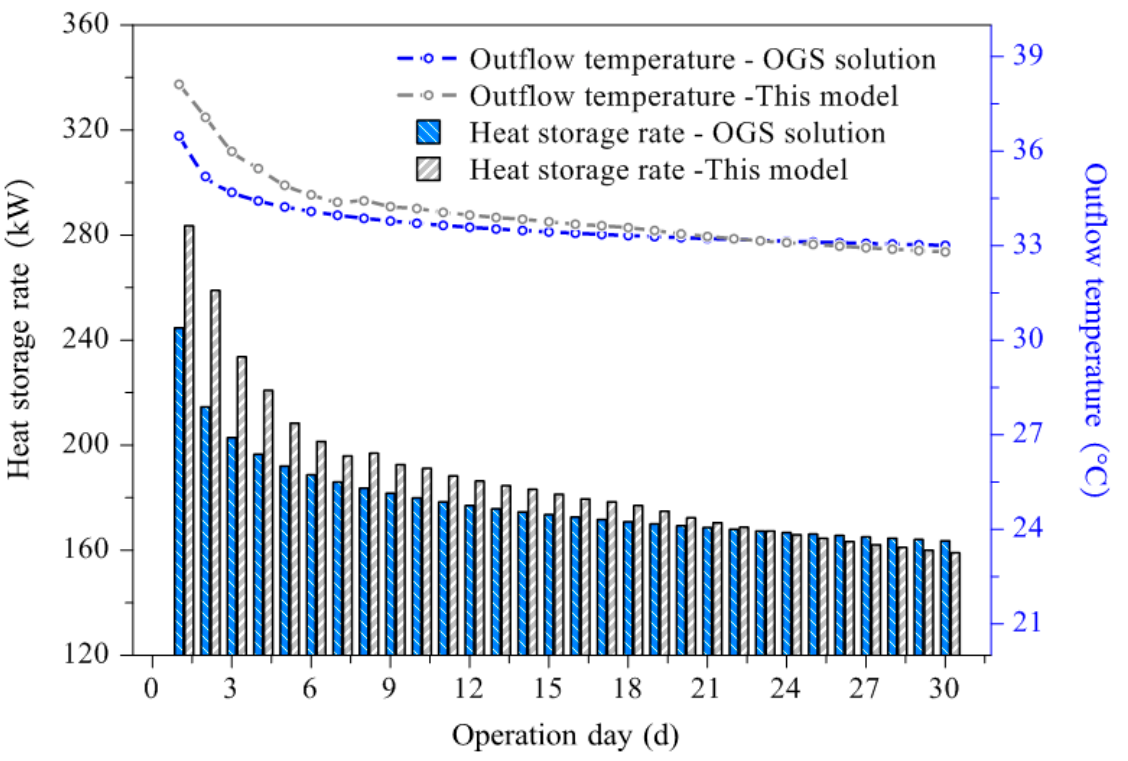
Figure 8. Evolution of heat storage rate and outlet temperature during the low temperature heat storage days.